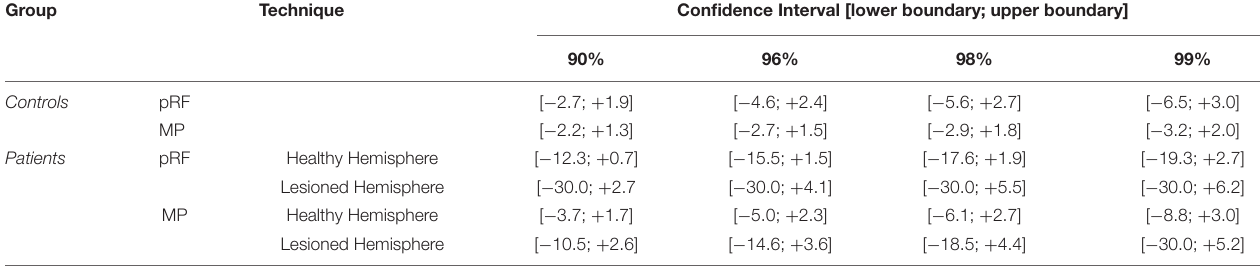
TABLE 2 | CI boundaries of VF sensitivity.